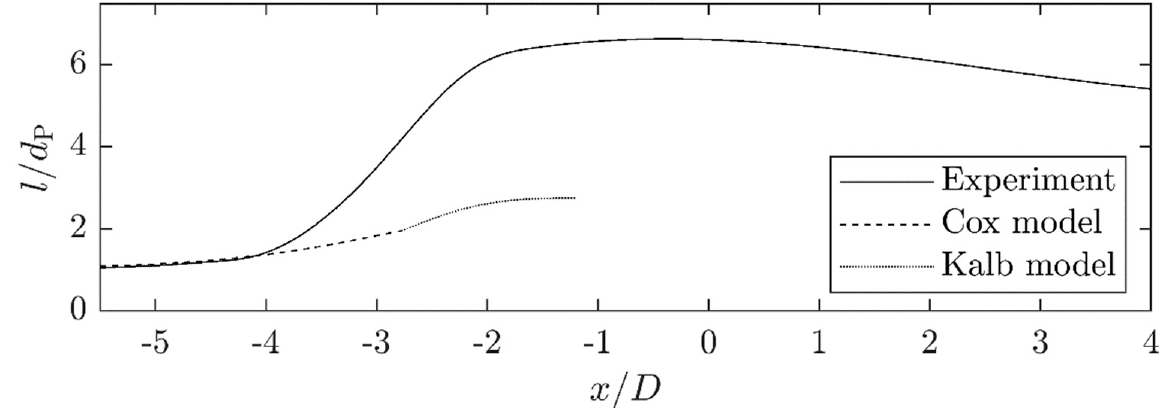
Table 4. Summary of the experimental and numerical results concerning drop elongation and its deviation for the different cases.